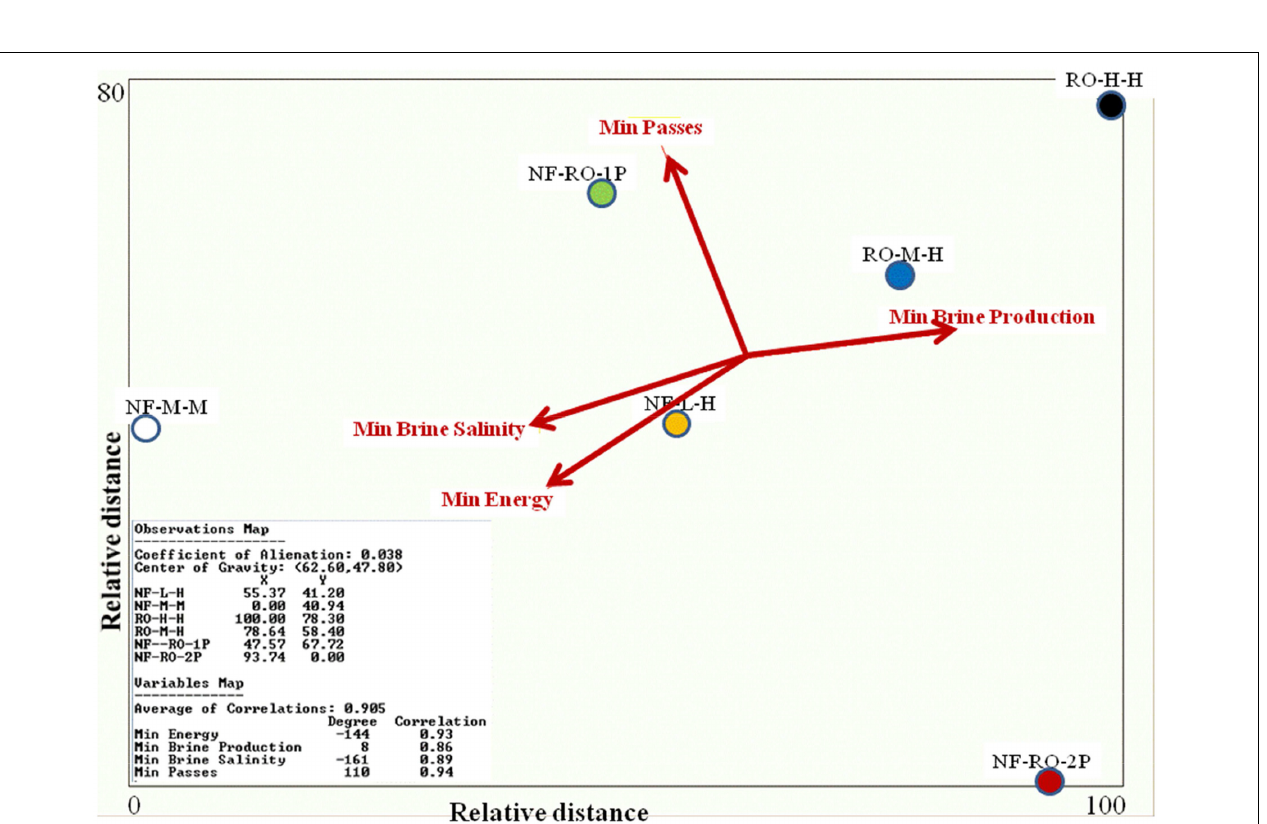
FIGURE 2 | MDS map, generated by the proposed method (CoPlot): NF and RO configuration performance (at a permeate flux of 20l/m 2 -h, six elements per vessel). Design: (i) one pass with ESNA1-LF-LD membranes (code NF-L-H); (ii) one pass with ESNA1-LF2-LD membranes (code NF-M-M); (iii) one pass with CPA5-MAX membranes (code RO-H-H); (iv) one pass with ESPA4-MAX membranes (code RO-M-H); (v) one pass with ESNA1-LF2-LD membranes at the first stage and ESPA4-MAX membranes at the second stage (code NF-RO-1P); and (vi) two pass with ESNA1-LF2-LD membranes at